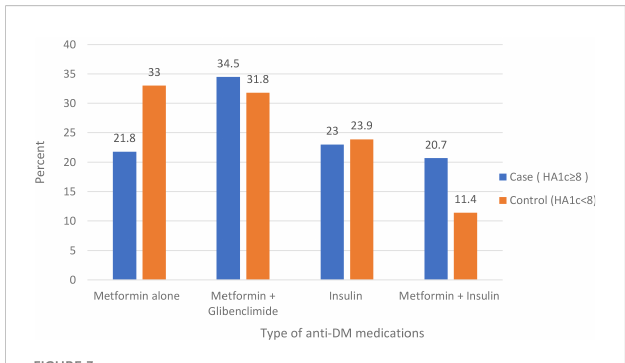
FIGURE 3 Type of anti-DM medications among type 2 diabetes mellitus patients at the DM clinic of UOGCSH, Northwest Ethiopia,